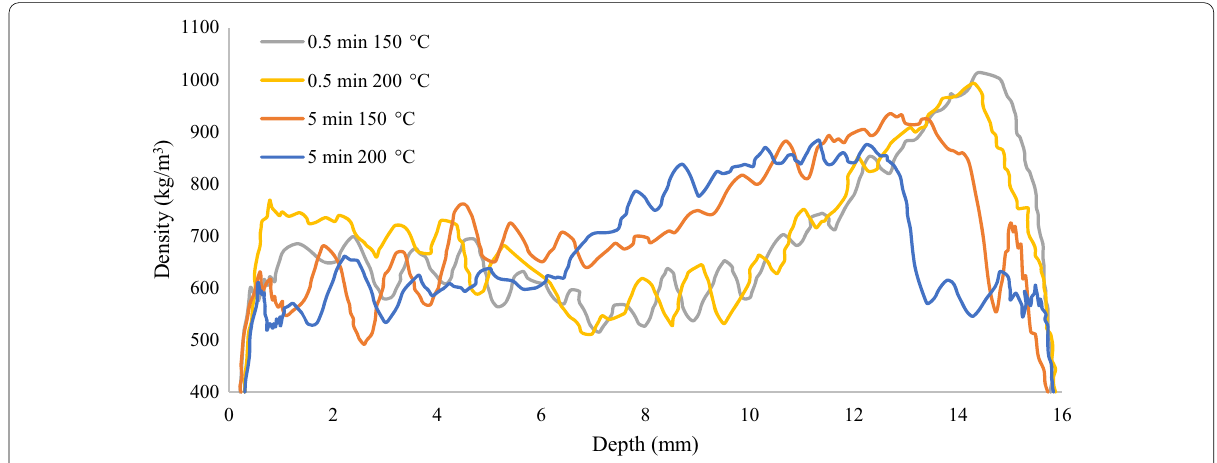
Fig. 10 Variations in density with depth in densified timber ( reproduced from Laine et al.